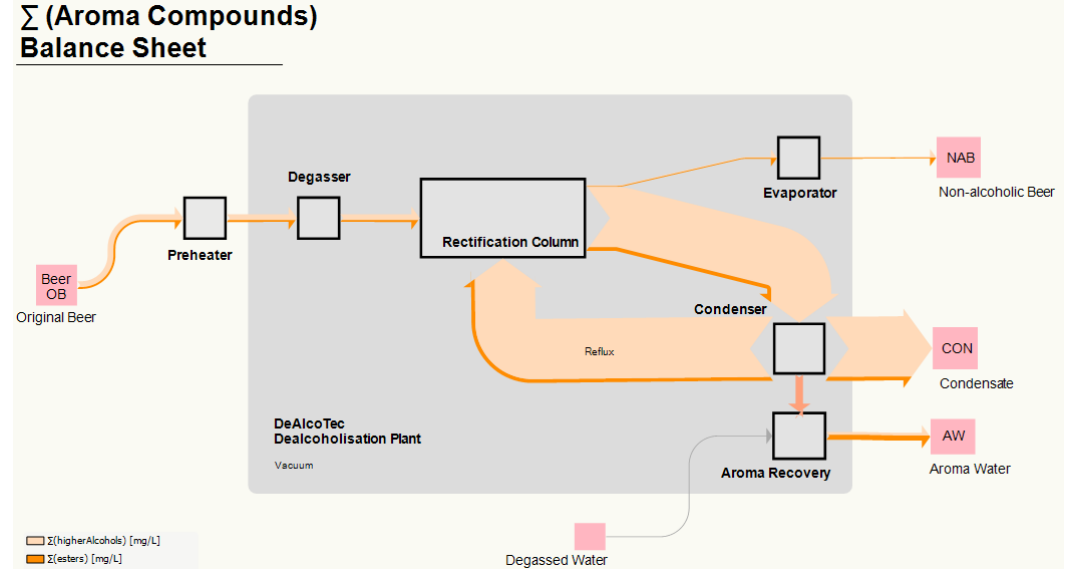
Figure 5. Balance sheet and distribution of the sum of esters (i.e., ethyl acetate, isobutyl acetate, ethylbutanoate, 3-methylbutyl acetate, 2-methylbutyl acetate and ethylhexanoate) and higher alcohols (e.g., propanol, 2-methylpropanol, 3-methylbutanol and 2-methylbutanol) in the DeAlcoTec ® thermal dealcoholisation system. The dealcoholisation experiment was conducted at an evaporation temperature of 36 °C, a condenser temperature of 10 °C and a reflux rate of 60 L h −1 . The volume flow rate for degassed water was 60 L h −1 . The pink squares represent the initial (beer OB) and final products (non-alcoholic beer NAB, condensate CON and aromawater AW) of the dealcoholisation process. The black squares/rectangles depict the single unit operations in the